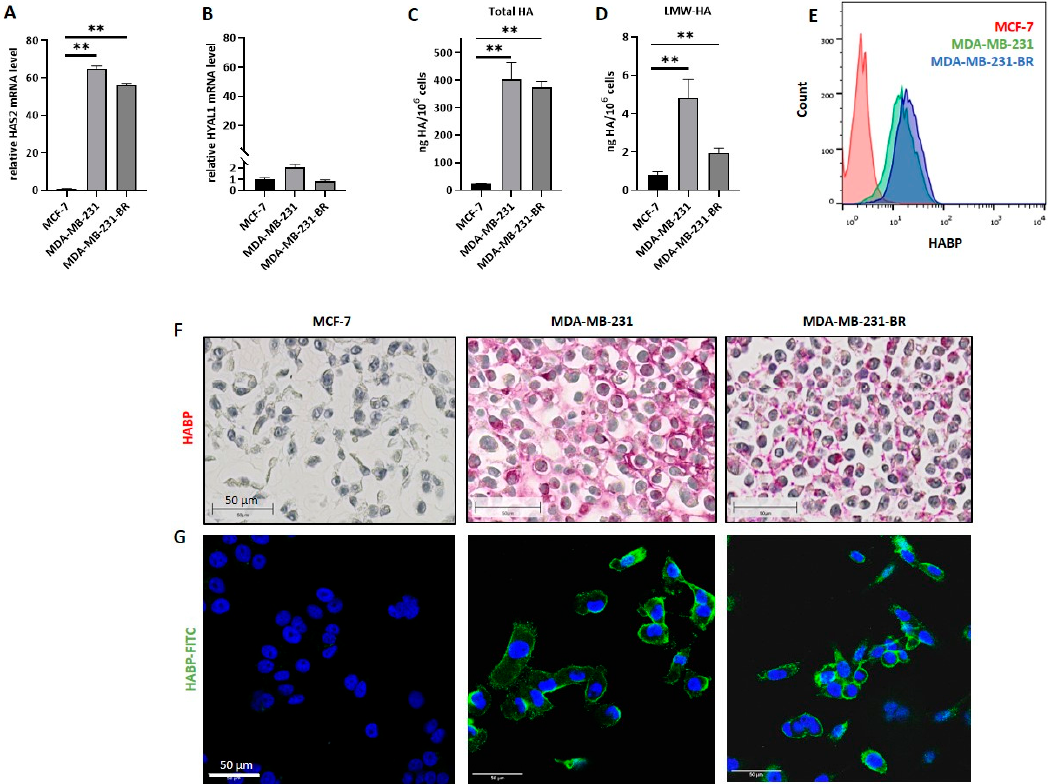
Figure 1. Hyaluronan metabolism in breast cancer (BC) cell lines of different molecular subtypes. The relative mRNA expression level of ( A ) hyaluronan synthase 2 ( HAS2) and ( B ) hyaluronidase 1 ( HYAL1) was measured by qRT-PCR. Values are normalized to corresponding GAPDH expression ( n = 3). ( C ) Bar graph displaying ELISA results on secreted hyaluronan (HA) levels (ng/10 6 cells) of MCF-7, MDA-MB-231, and MDA-MB-231-BR. Cell supernatant was collected and used for HA-ELISA; one representative experiment with three replicates out of three experiments is shown ( n = 3). ( D ) Levels of secreted low-molecular-weight HA (LMW-HA) (ng/10 6 cells) of MCF-7, MDA-MB-231, and MDA-MB-231-BR measured by HA-ELISA; one representative experiment with duplicates out of three experiments is shown ( n = 3). ( E ) Histogram showing the quantified amount of surface HA, measured via flow cytometry using biotinylated HA binding protein and FITC-conjugated Streptavidin. One representative experiment is shown ( n = 3). ( F ) Immunohistochemical staining of HA (pink) using biotinylated HA binding protein of all three cell lines. Representative picture out of 3. Scale bars represent 50 µm. ( G ) Immunofluorescence staining of nuclei (DAPI, blue) and HA (FITC, green) using biotinylated HA binding protein and FITC-conjugated Streptavidin for all three cell lines. Representative picture out of 3. Scale bars represent 50 µm. Statistical significance was determined using unpaired two-tailed Student´s t-tests. The assumption of homogeneity of variance was tested using Levene´s Test of Equality of Variances ( p > 0.05). Values are means +/ − s.d., ** p < 0.005.